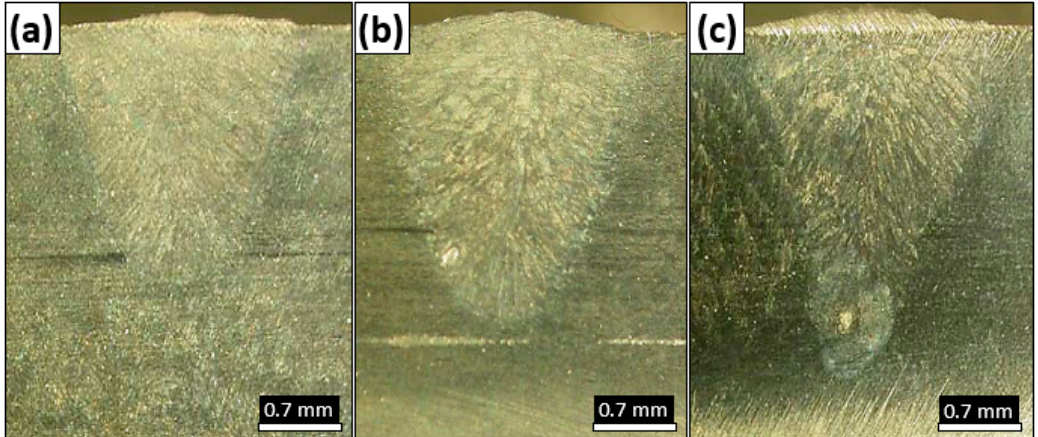
Figure 3. Macrographs of cross sections of laser sheet welds formed using a 0.5 m/min welding speed, − 2 mm defocusing distance, 15 L/min Argon flowrate at different pulse energies ( a ) 4.5 kW; ( b ) 6.5 kW and ( c ) 8.5 kW.